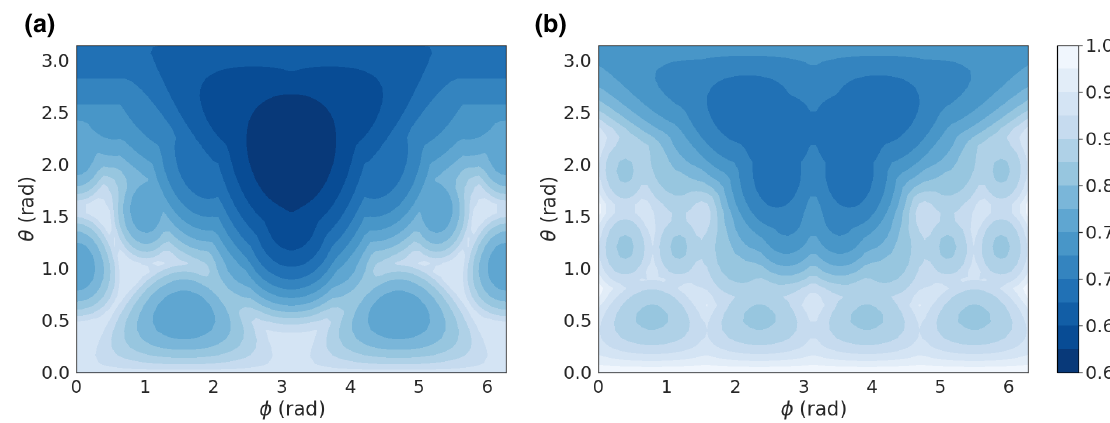
FIG. 3. Application of program (6) to S (θ , φ) = { ρ x , ρ z , ρ r (θ , φ) } . Levels are the maximum visibility α such that preparation set α S (θ , φ) has a classical model. (a) For the | Y | = 6 icosahedron measurements, η ≈ 0.79, and program (6) can be applied directly. (b) A rhombicuboctahedron corresponds to | Y | = 12 PMs and η ≈ 0.86. As the number of deterministic strategies scales exponentially, the computation is only possible by iteratively optimizing over subsets of deterministic strategies.